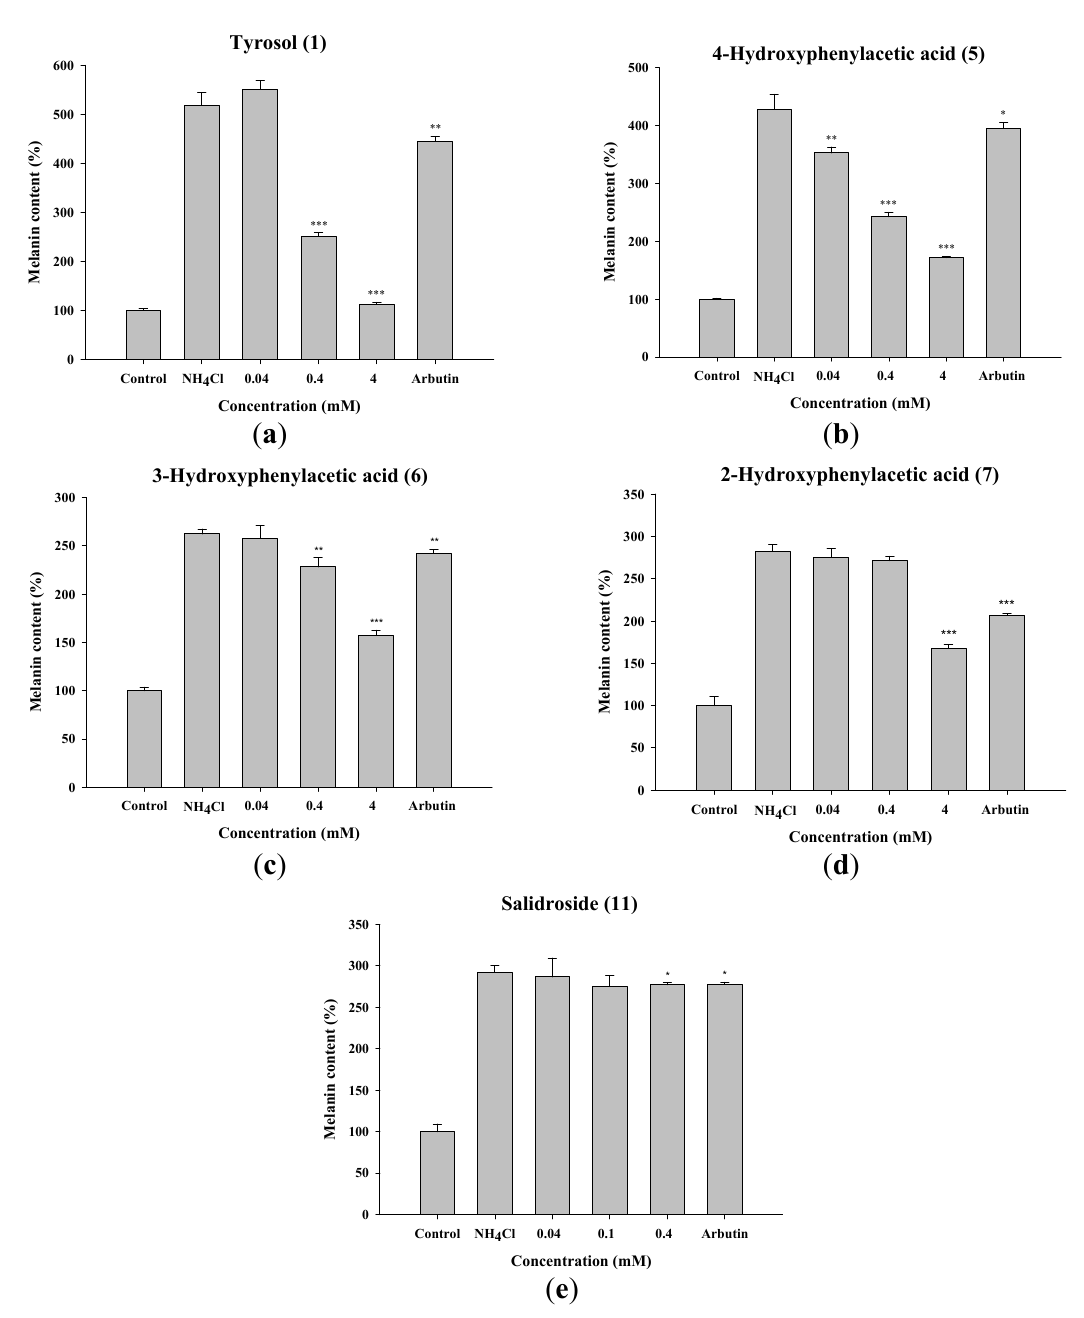
3-hydroxyphenylacetic acid ( 6 ) and salidroside ( 11 ) at 0.4 mM, by 4-hydroxyphenylacetic acid ( 5 ) at 0.04 mM and 2-hydroxyphenylacetic acid ( 7 ) at 4 mM. Figure 4. Melanin content (%) in B16F0 cells treated with ( a ) tyrosol ( 1 ); ( b ) 4-hydroxyphenylacetic acid (4-HA) ( 5 ); ( c ) 3-hydroxyphenylacetic acid (3-HA) ( 6 ); ( d ) 2-hydroxyphenylacetic acid (2-HA) ( 7 ) and ( e ) salidroside ( 11 ). ( * p < 0.05, ** p < 0.01, *** p < 0.001 vs . Control. Data represent means ± S.D. ( n =